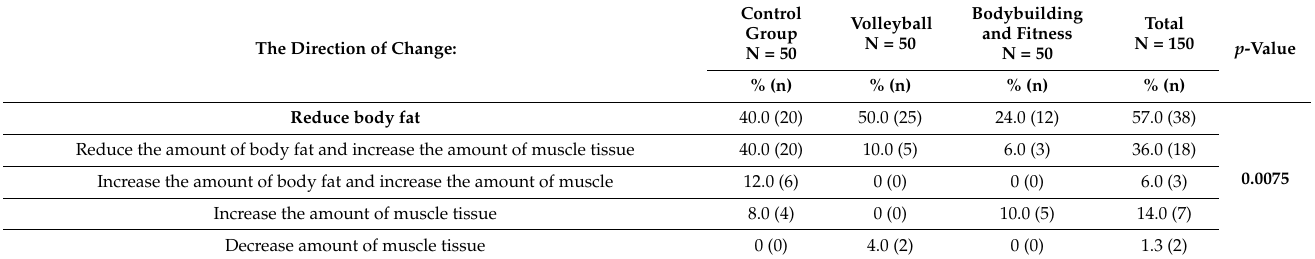
Table 6. Subjective directions of the desire to change their figure among the studied groups of